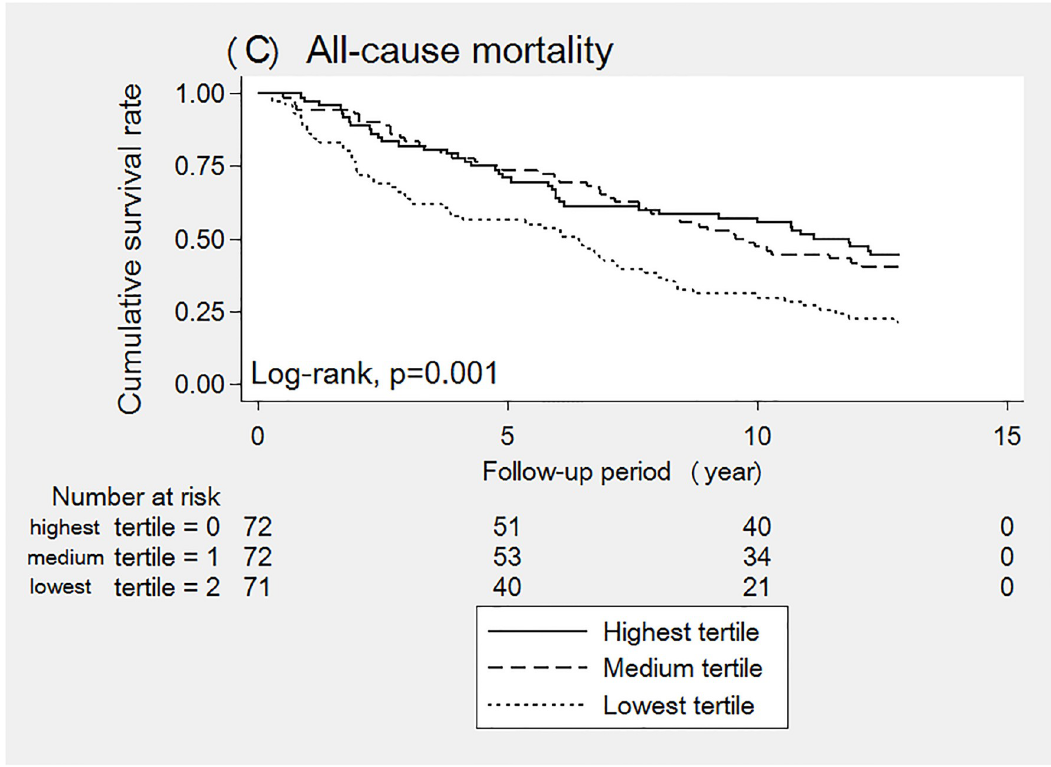
Fig 2. Cumulative survival rate for all-cause mortality according to the lowest, medium, and highest relative CD34 + cell tertiles.